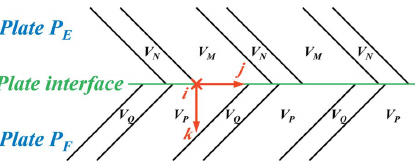
Figure 8 Illustration of the variant composition in the vicinity of the plate interface based on the morphological features described in Section 3.1 and Section 3.2. The ijk coordinate frame is orthonormal, with i parallel to the intersection line of the twinning plane of variant pair V P and V Q and the plate interface, k normal to the plate interface, and j the vector cross product of k and i